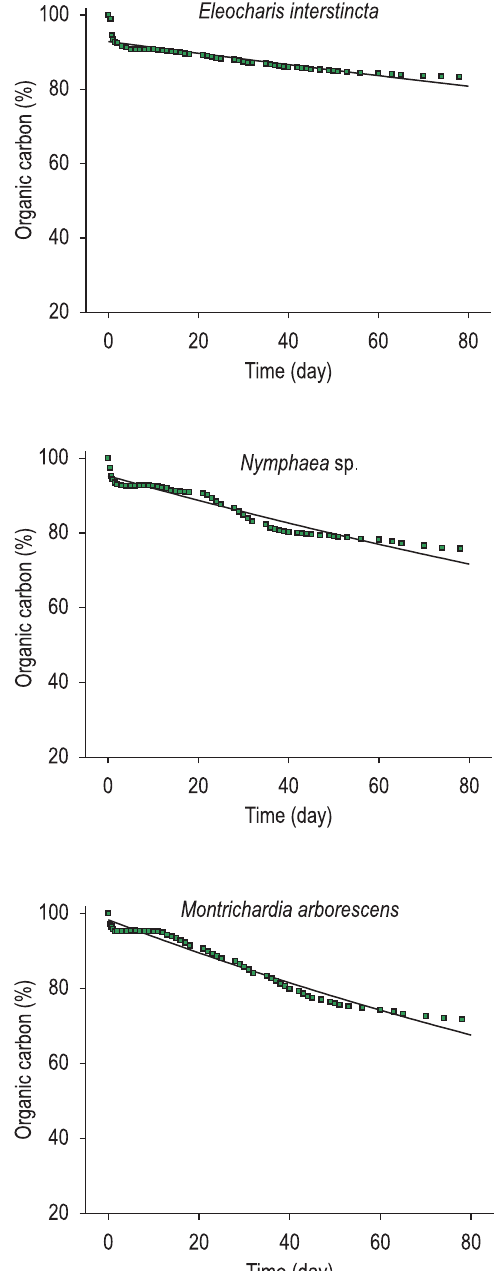
Figure 3. Organic carbon decay during anaerobic mineralization of E. interstincta , Nymphaea sp. and M. arborescens